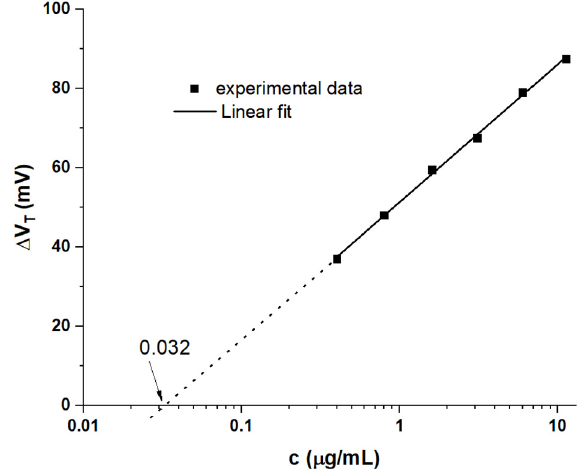
Figure 7. Potentiometric response metric ∆ V T (c) against a logarithmic RBD spike concentration scale. The intercept corresponds to c st .